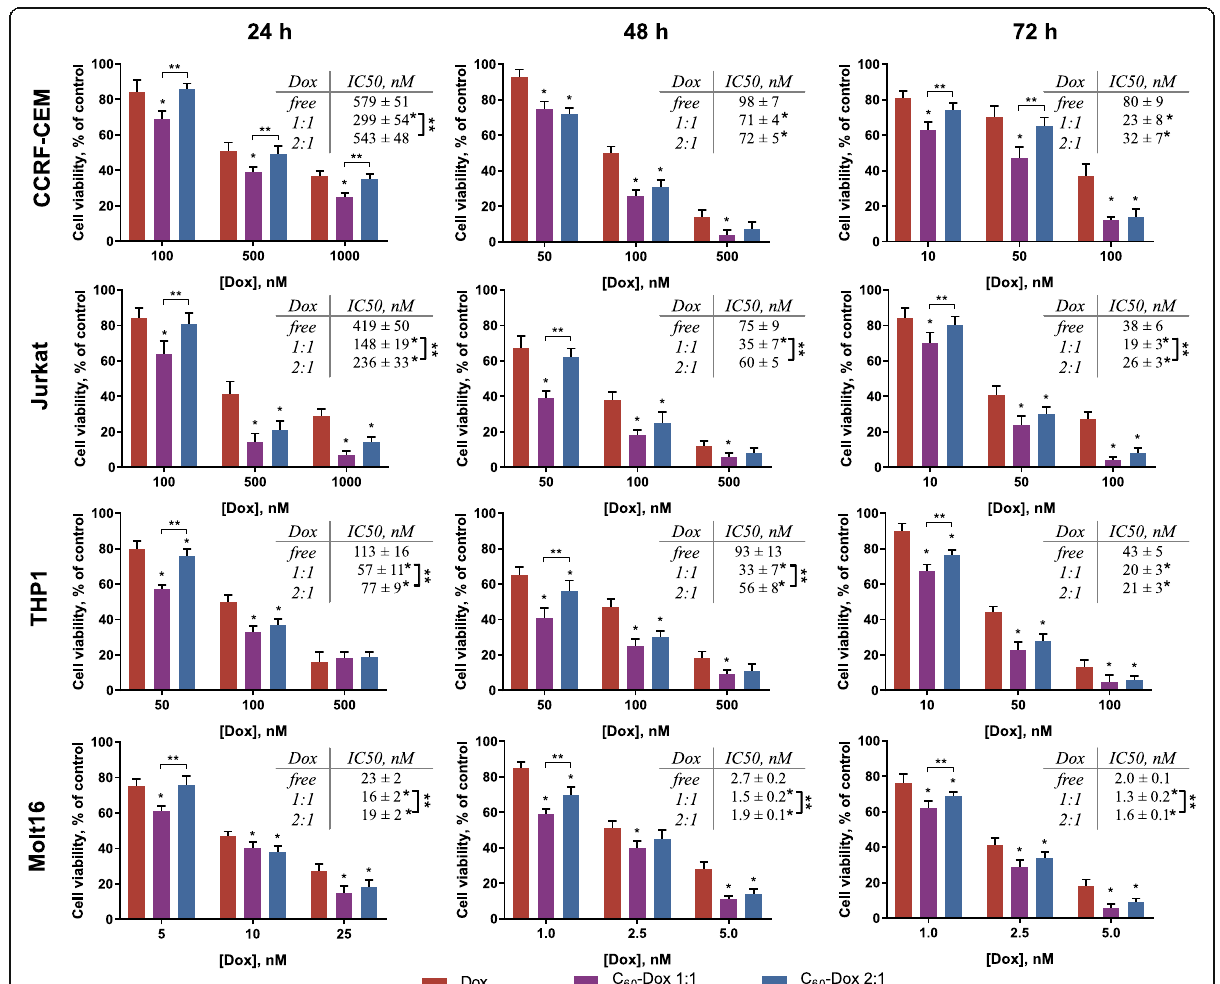
Fig. 4 Viability of CCRF-CEM, Jurkat, THP1 and Molt16 leukemic cells, treated with equal doses of free Dox or C 60 -Dox complexes for 24, 48, and 72 h (* p ≤ 0.05 in comparison with the free Dox, ** p ≤ 0.05 in comparison with the C 60 -Dox 1:1 complex, n =